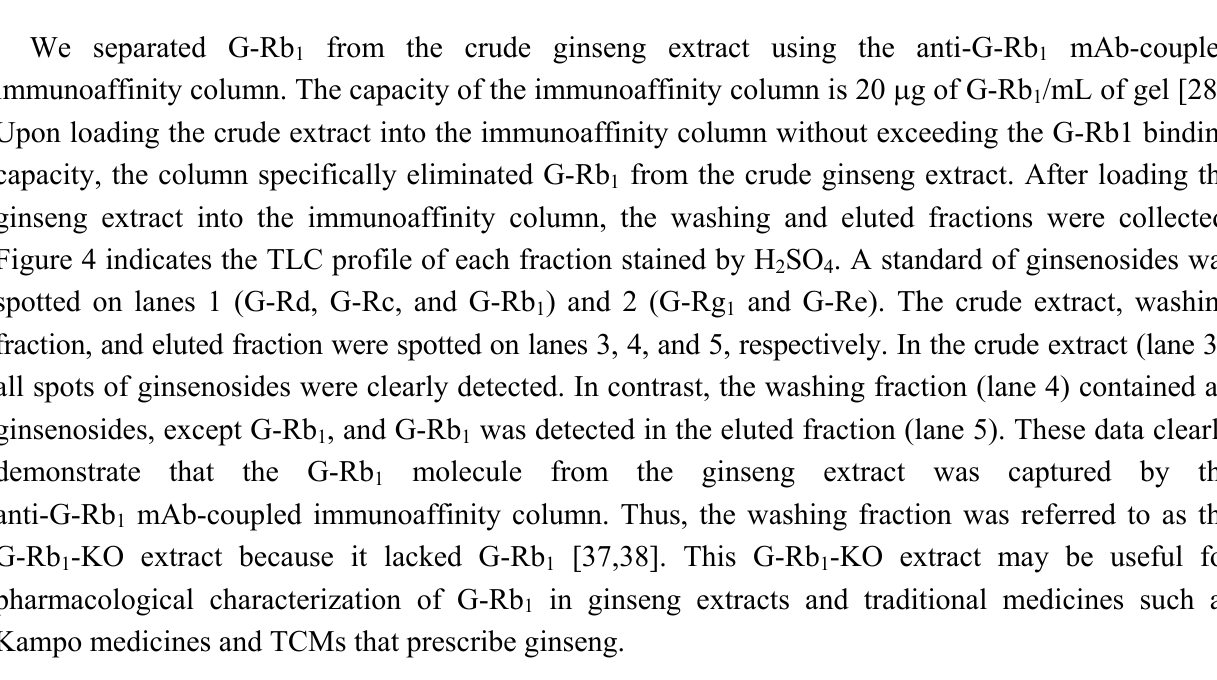
from the P. ginseng crude 1